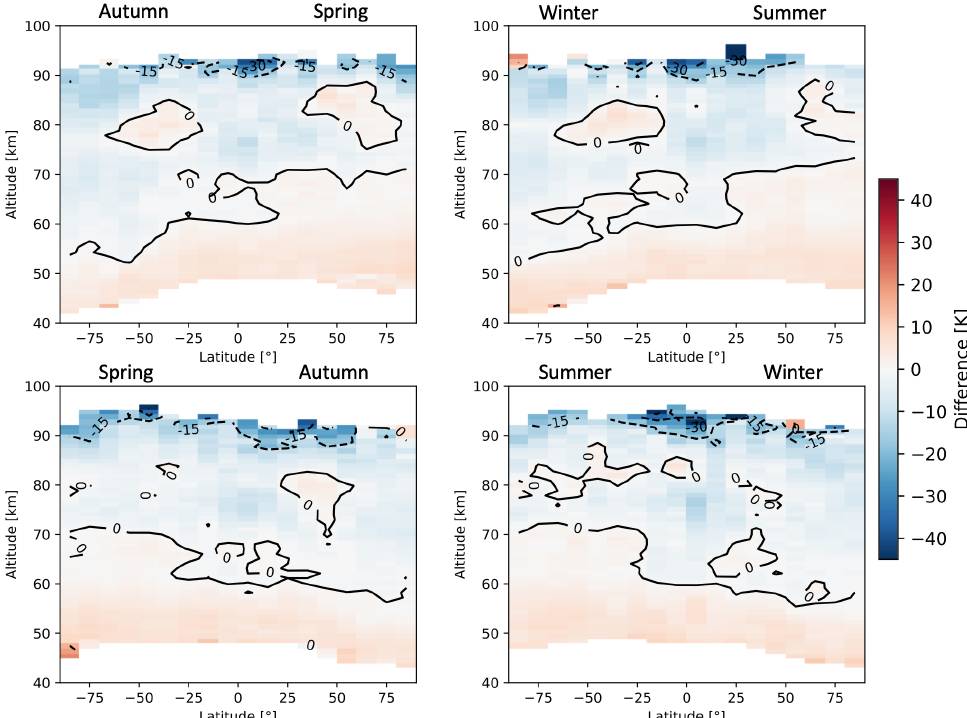
Figure A22. Seasonal zonal means of temperature FM19 SMR–MIPAS middle atmosphere absolute differences averaged over the time period indicated in Table 2. The seasons are intended as astronomical seasons, i.e. each starting at the respective solstice or equinox. Atmos. Meas. Tech., 14, 5823–5857,